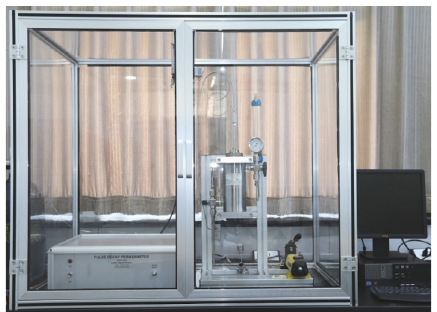
Figure 3: Setup to measure permeability of tight rock through pressure-pulse-decay method.